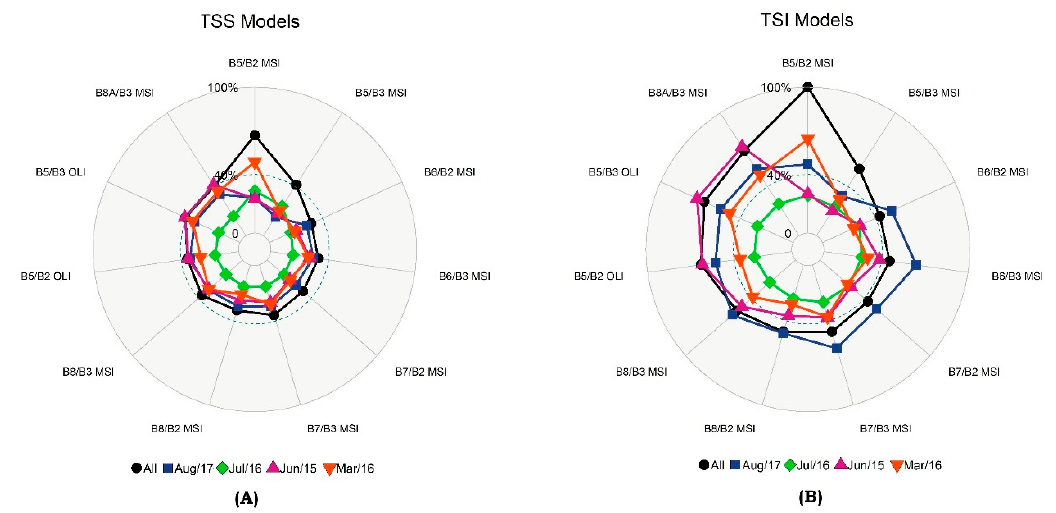
Figure 6. The MAPE values (%) obtained through a Monte Carlo simulation for R rs,sim_sat for both sensors using band-ratio models based on the Campaign Dataset: ( A ) The band-ratio models for TSS and ( B ) the band-ratio models for TSI. The validation sample size for each campaign: June 2015 n = 9; March 2016 n = 5; July 2016 n = 8; and August 2017 n = 5. The R² and RMSE are in the Supplementary Files A. “All” at the bottom of the legend for TSS and TSI refers to MAPE values for the All Dataset models (The values are in Table 3).